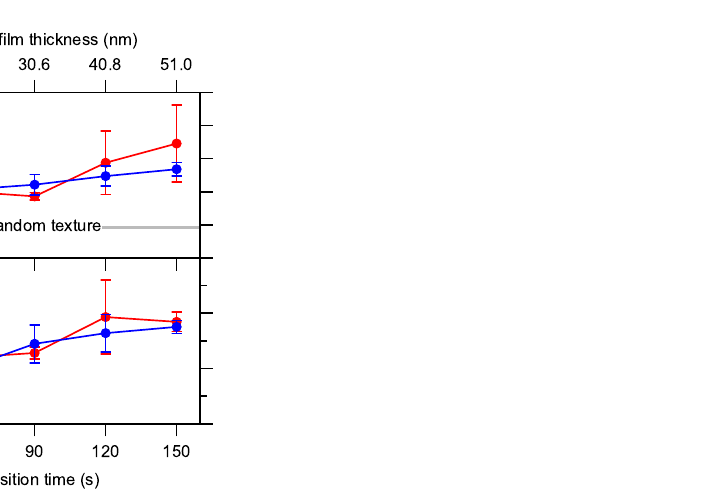
Figure 7. ( a ). The ratio between the diffraction intensity of the (111) and (200) Bragg reflection as function of the deposition time (or apparent film thickness). The grey line indicates the same ratio for a random textured silver film. ( b ). The domain size as calculated from the integral breath of the (111) Bragg reflection. The Al seed layer has a nominal thickness of 0.5 nm. All films were deposited and analyzed three times.